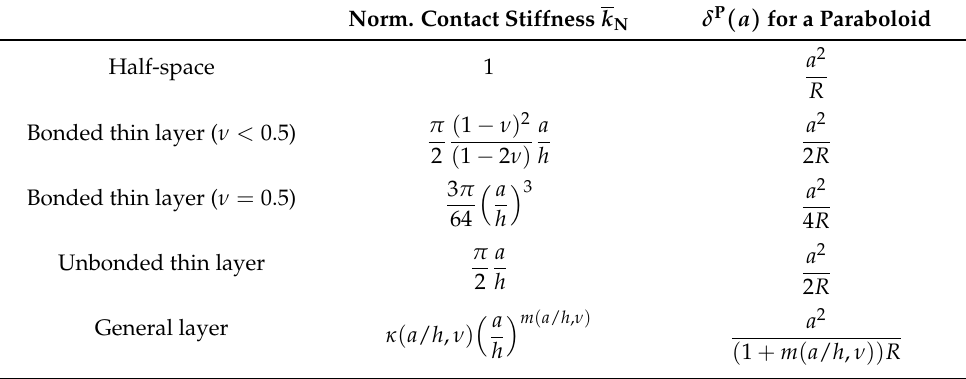
Figure 4. Normalized contact pressure distribution under a cylindrical flat punch indented into a bonded incompressible layer ( ν = 0.5) for different ratios of radius to layer thickness a / h . Table 1. Normalized contact stiffness and relation of indentation depth and contact radius δ ( a ) for a paraboloid with radius of curvature R